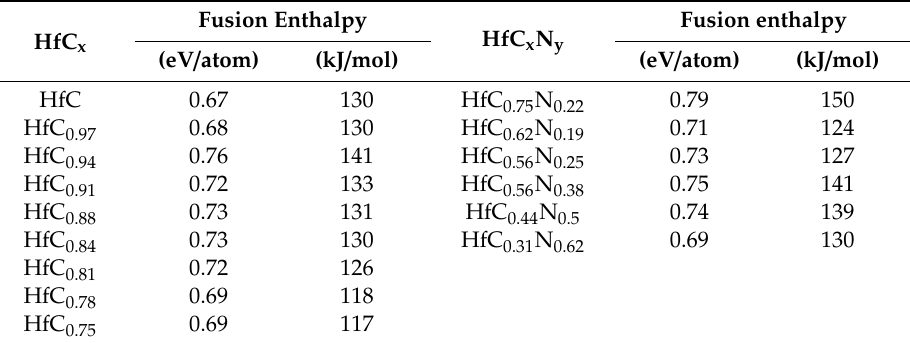
Table 3. Fusion enthalpies of HfC x and HfC x N y from DFT calculations